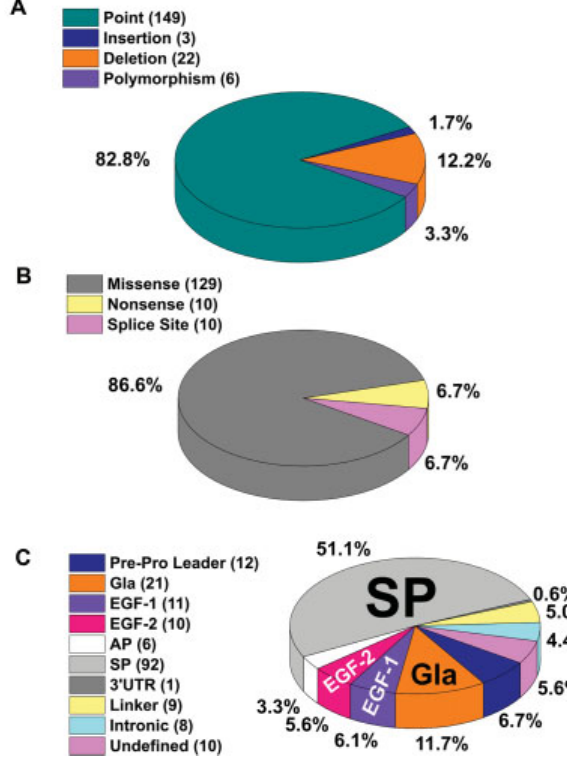
Fig. 3 Distribution of the 180 variants identi fi ed within the F10 gene. The panels ( A – C ) illustrate the breakdown of the 180 factor X (FX) variants by variant type, effect and location within the F10 gene sequence. The charts illustrated here distinguish the nondisease associated polymorphisms from the disease-causing genetic variants. ( A ) Relative frequency of four different types of genetic variants in the F10 gene; ( B ) Genetic classi fi cation of 149 point variants in the F10 gene; ( C ) Relative distribution of the 180 FX variants across the F10 gene and within the protein domains. The six unde fi ned variants include two unique deletions that stretch across exons 1 – 6 and 1 – 8, respectively, one unde fi ned deletion and three missense variants preceding the F10 coding sequence. AP, activation peptide; EGF, epidermal growth factor; GLA, γ -carboxyglutamic acid; SP, serine